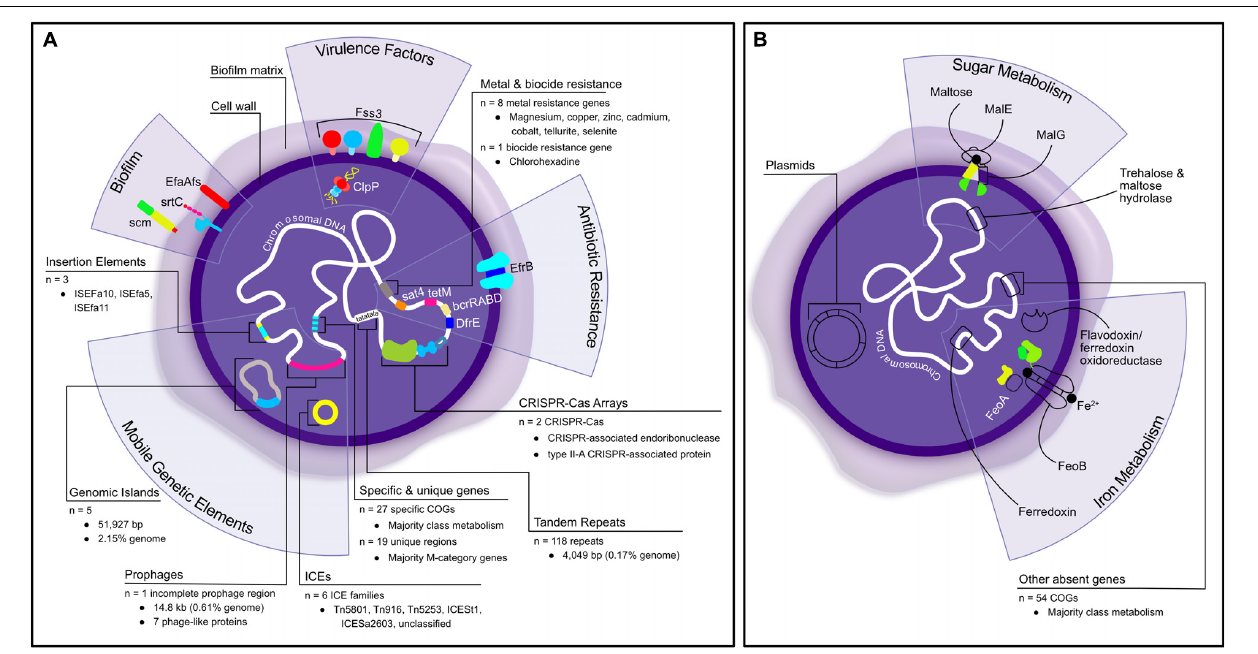
FIGURE 5 | Schematic summary of the present and absent genetic elements and pathogenic properties in E. lacertideformus identified through in silico investigations into the organism’s genome. (A) Depicts a summary of the components identified in E. lacertideformus , (B) illustrates components identified to be lacking in the genome of E. lacertideformus during comparative genomics. Absent components and mechanisms are outlined with a black border only and have no color fill. Labeled descriptions for each of the components are clearly